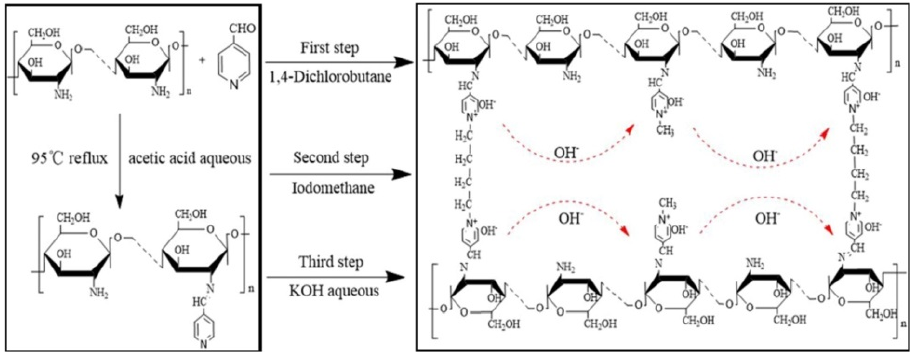
Figure 2. Synthesis scheme and molecular structure of CS-PY-DL x . Reprinted with permission from Ref. [22]. Copyright 2019 Elsevier.